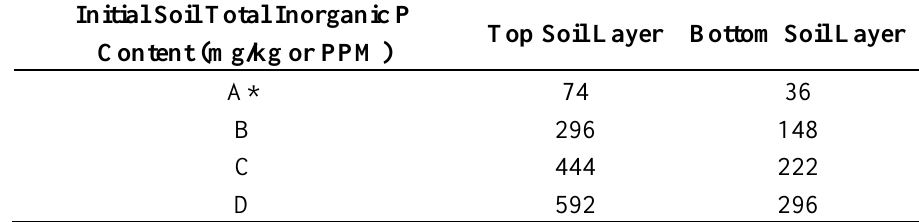
Table 6. Various initial soil total inorganic P contents used for AnnAGNPS simulations.